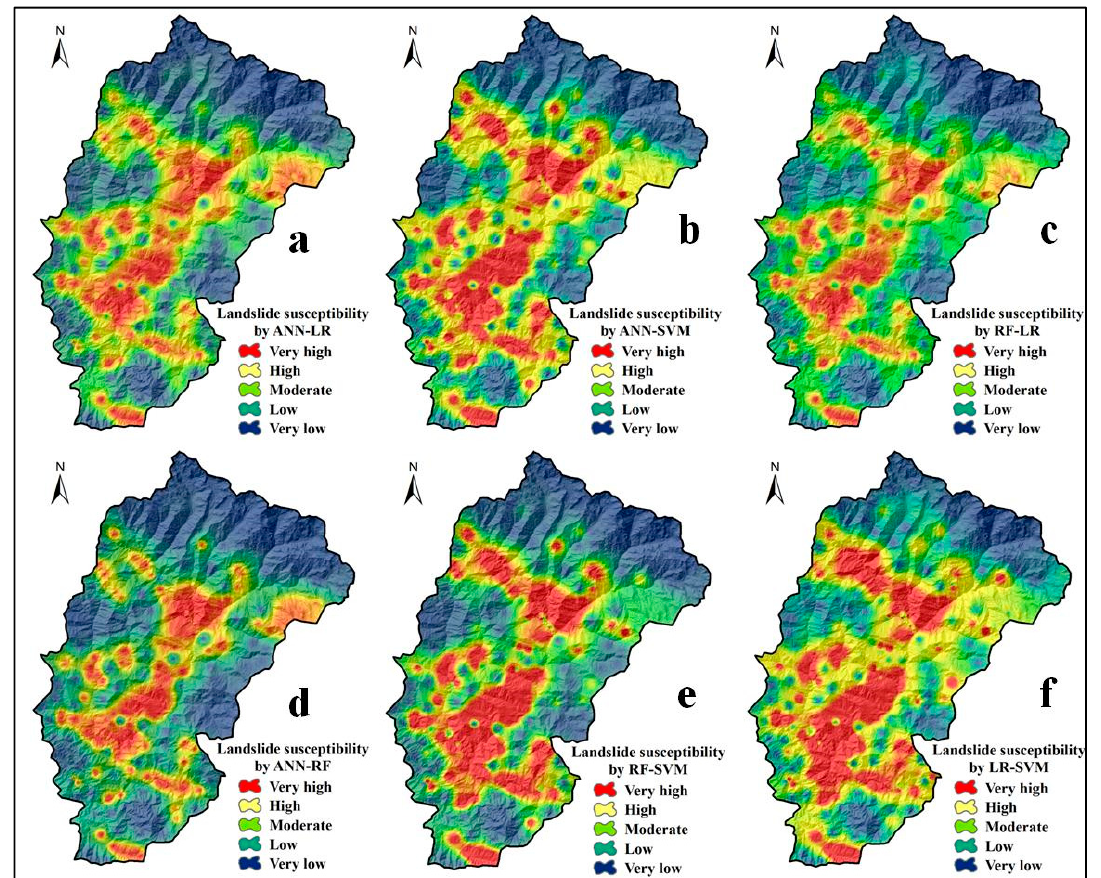
Figure 7. Landslide susceptibility mapping using ensemble of two models: ( a ) ANN-LR, ( b ) ANN-SVM, ( c ) LR-RF, ( d ) ANN-RF, ( e ) SVM-RF, and ( f ) LR-SVM.